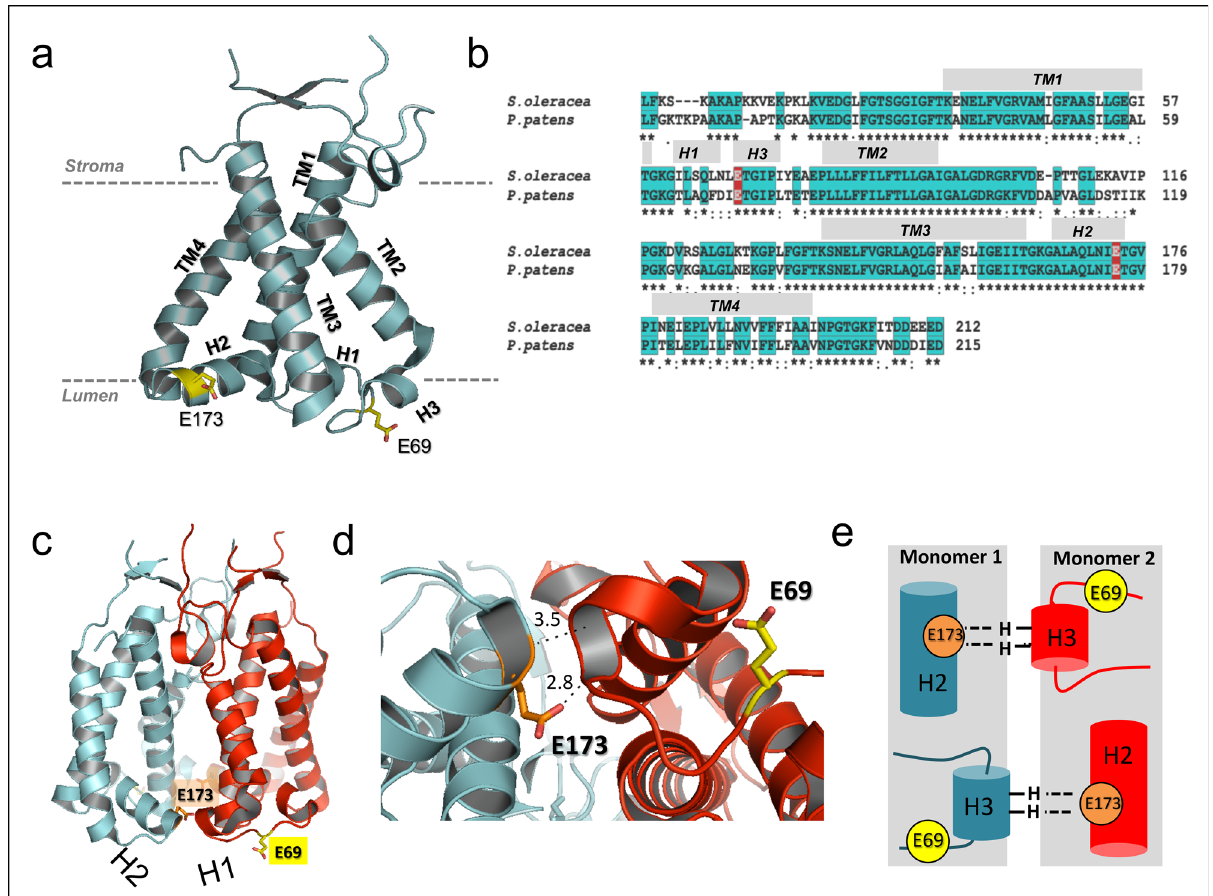
Fig. 1 Structure and sequence of PsbS. PsbS structure, sequence, location of active Glu-1 and Glu-2 and intradimer hydrogen bond interactions. a Structure of spinach PsbS ( PDB-ID 4RI2 20 ), highlighting the active Glu (E69 and E173 in yellow). Part of the stromal loop between TM2 and TM3 is not resolved in the X-ray structure. b Amino acid sequences of spinach ( S. oleracea ) and P. patens PsbS, with the two active Glu highlighted in red. c X-ray structure of the PsbS dimer with the active Glu-1 (E69, in yellow) and Glu-2 (E173, in orange). d Detail of dimerization interface viewed from the luminal side. Helix H2 containing Glu-2 (E173) connects with the luminal loop containing Glu-1 (E69) of the adjacent monomer, via hydrogen bonds from the Y75 backbone amide to the E173 side chain and the I74 backbone amide to the E173 backbone carbonyl. e Schematic picture of the inter-monomer stabilizing interactions at the luminal side, involving Glu-2 (E173) in helix H2 and the 3 10 helix/luminal loop containing Glu-1 (E69).